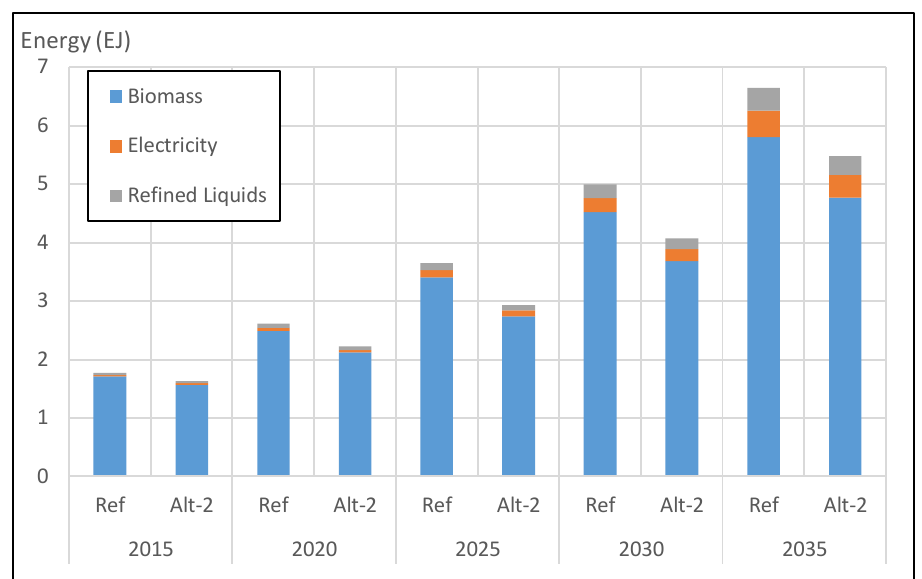
Figure 9. Comparison of Energy Demand in the Building Sector due to Biomass Efficiency Improvement, Ref. vs. Alt-2 Scenario (Unit: EJ).